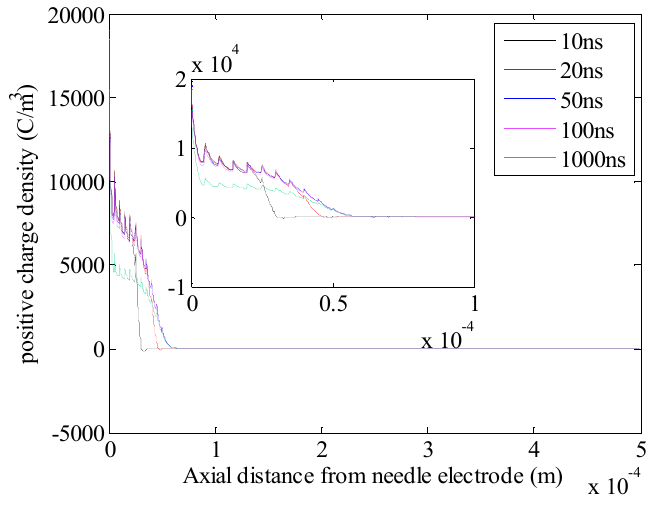
Figure 18. Positive charge density distribution along the needle-sphere axis as a response to 1.2 PDIV with 5 mm needle-sphere electrode